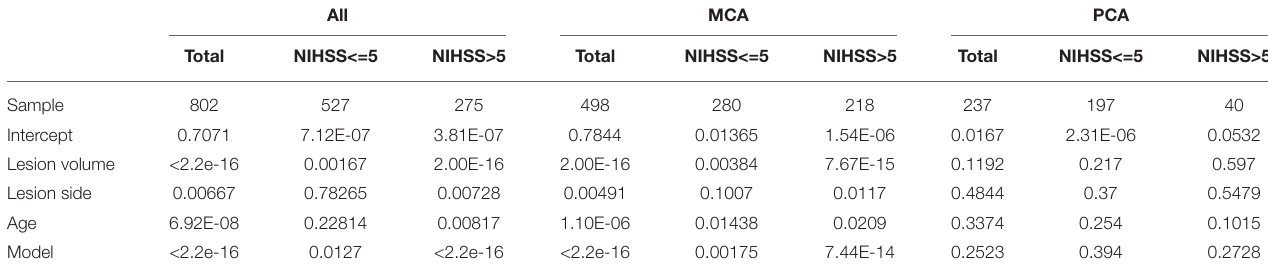
TABLE 2 | P -values for the generalized linear models and covariates of the models to predict the NIHSS.